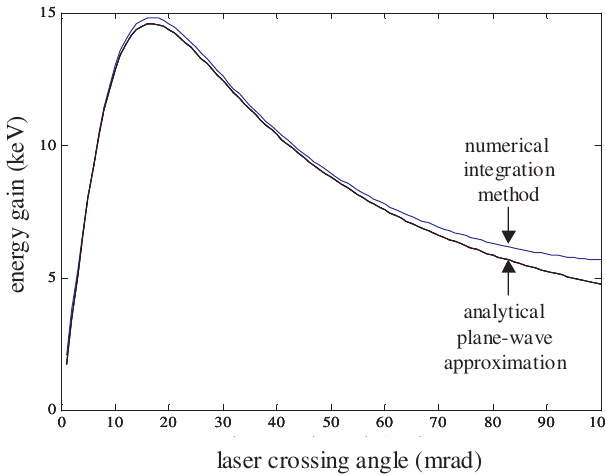
FIG. 3. (Color) Expected electron beam energy gain versus laser-crossing angle with (cid:7) (cid:1) 60 ; E